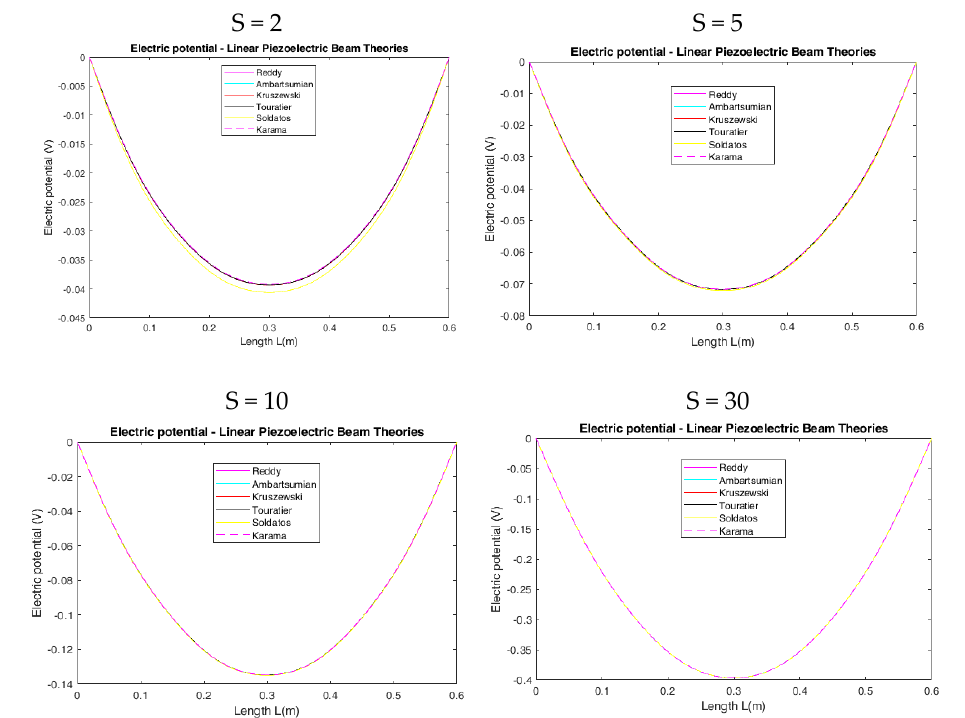
( ) ϕ  Figure 4. Comparison of electric potential (cid:101) ϕ through the length of the beam at ( x , z = 0 ) for various x z 0 = , for vari- Figure 4. Comparison of electric potential through the length of the beam at aspect ratios ( S = 2, 5, 10, 30 ) and for all models with higher order shear deformation terms. ( ) S 2 5 10 30 = , , , and for all models with higher order shear deformation terms. ous aspect ratios